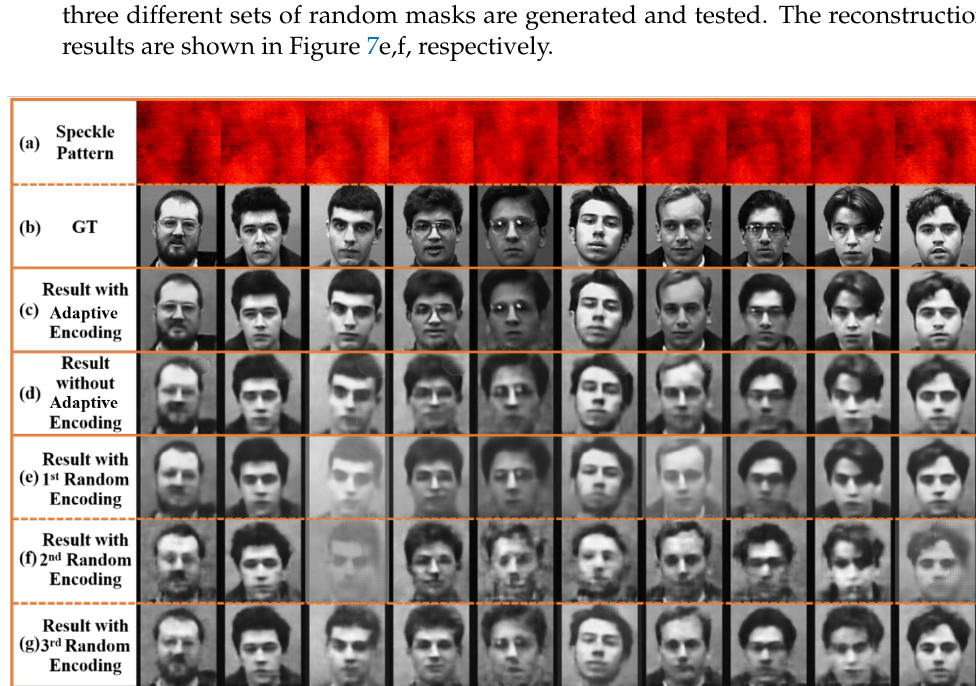
Figure 7. Comparison of AESINet-R reconstruction results with different encoding methods. ( a ) The Speckle pattern. ( b ) The Ground Truth (GT) of the hidden target. ( c ) AESINet-R test set reconstruction results after adaptive encoding by AESINet-E. ( d ) The AESINet-R reconstruction result when the speckles without adaptive encoding as input. ( e – g ) The AESINet-R reconstruction result after speckle is modulated by randomly generated gaussian encoding